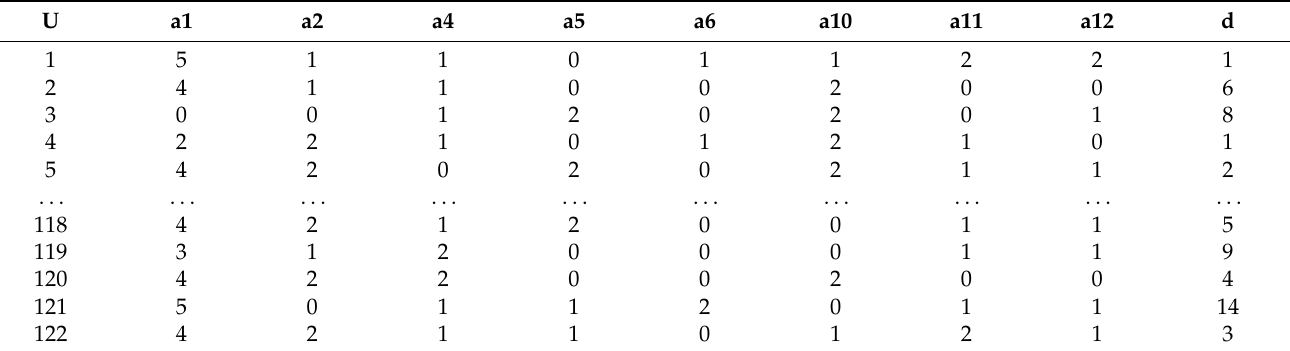
Table 8. Minimum decision table after reduction.